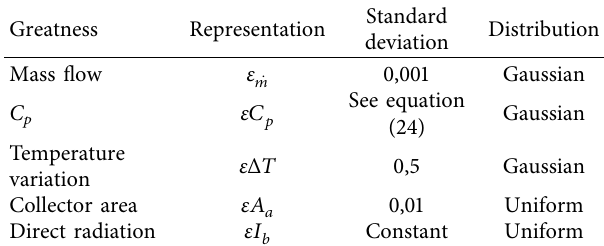
Table 2: Values of expanded